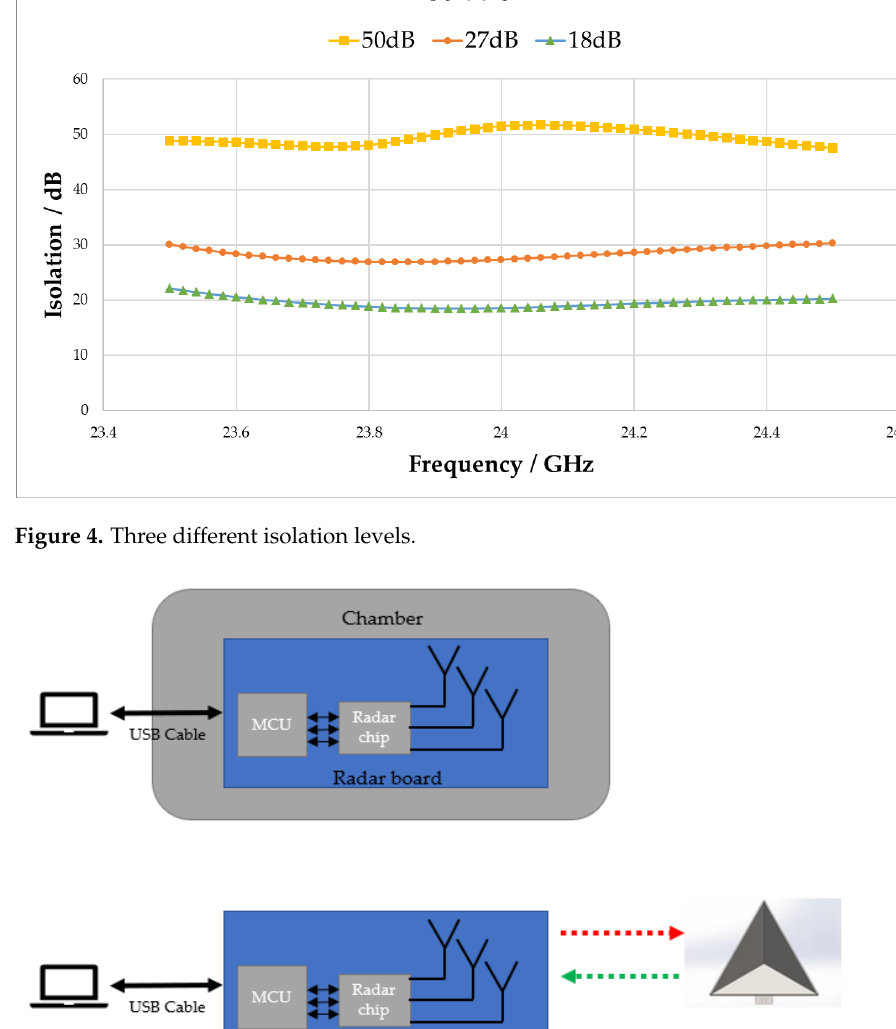
Figure 5. Experimental system block diagram.